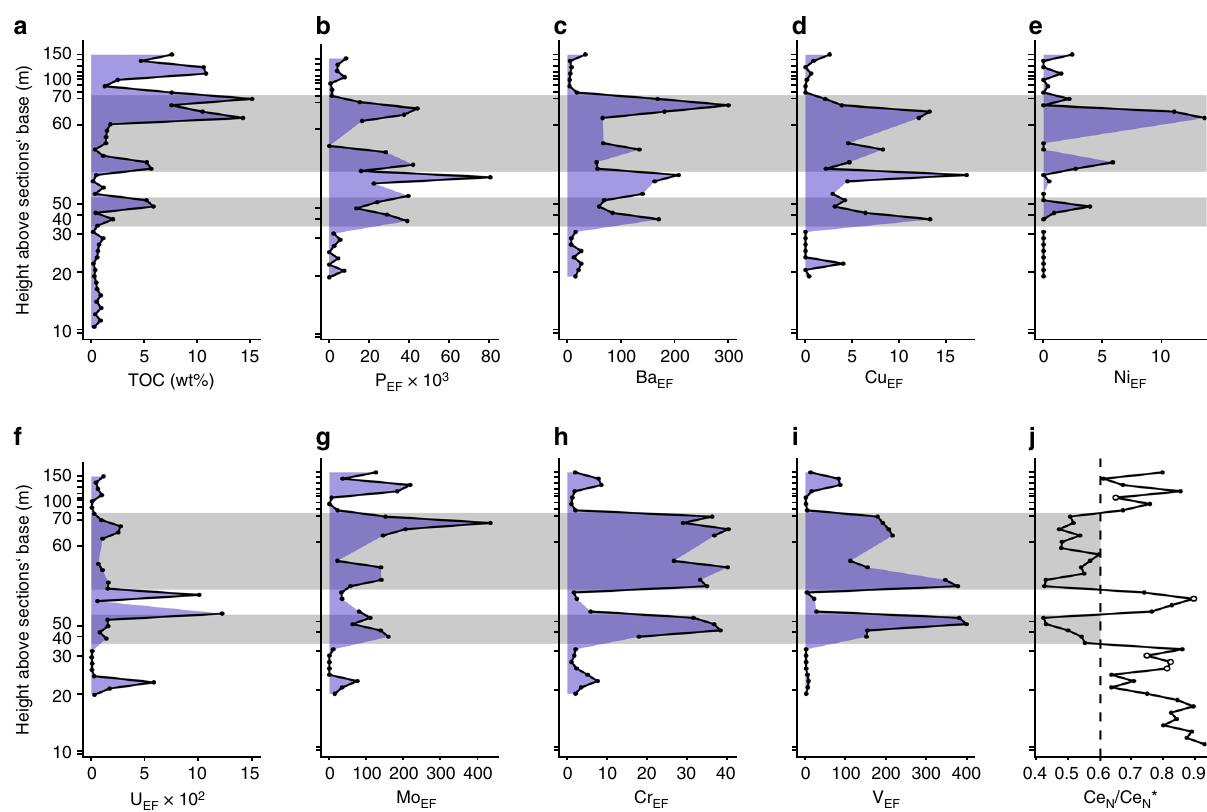
Fig. 3 TOC concentrations, EFs (Al and PAAS-normalized element concentrations) of redox-sensitive trace elements and Ce N /Ce N * at the Lijiatuo section. a Total organic carbon concentrations; b – i EFs of P, Ba, Cu, Ni, U, Mo, Cr and V are highest in organic-rich sediments and suboxic water as indicated by Ce N /Ce N * ( j , horizontal gray shades indicate the most oxic conditions, i.e., Ce N /Ce N * < 0.6). Open symbols mark samples with Pr N /Yb N > 1, indicating fl at, non-seawater REE patterns (cf. Fig. 1). Samples with < 3% detritus are not shown due to potential normalization artifacts resulting from propogation